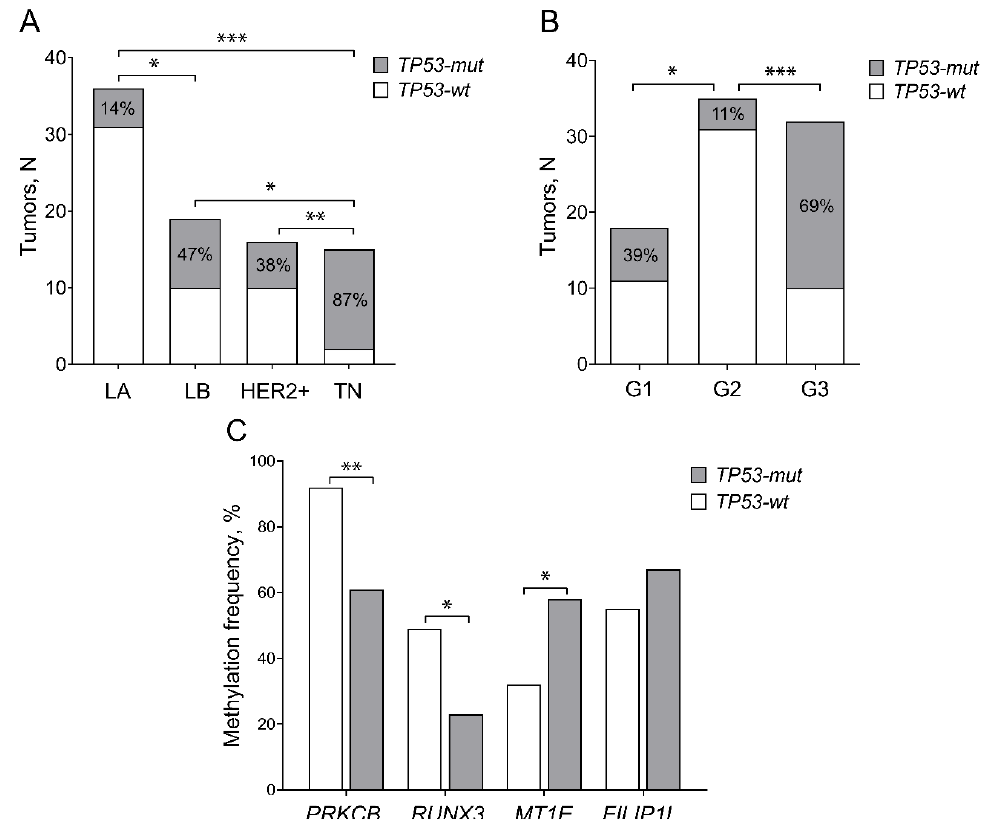
Figure 3. TP53 mutation distribution among breast cancer (BC) patients grouped according to intrinsic subtypes ( A ), tumor differentiation grades G ( B ), and methylation status of analyzed genes ( C ). G1 — good, G2 — moderate, G3 — poor differentiation; HER2+ — HER2 positive and LB HER2